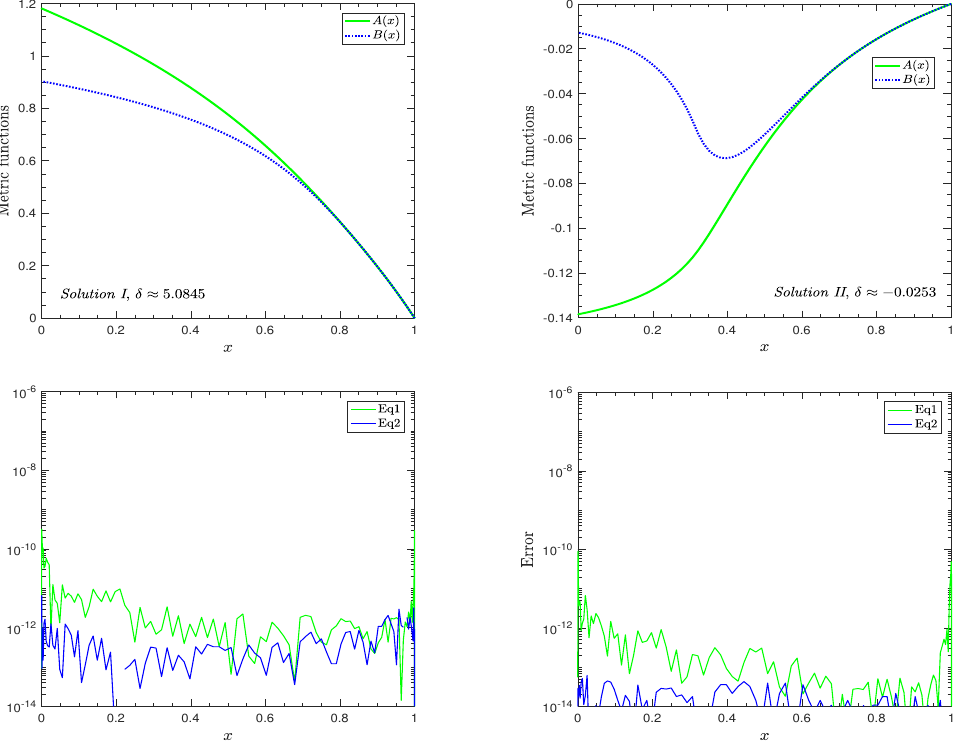
Figure 1 . Two non-Schwarzschild black holes for r 0 = 2. Top panel shows numerical results of functions A, B , and bottom panel shows the absolute value of the error in eqs. (A.1) and (A.2) { } (see appendix. A). The left and right panels correspond to solutions I and II , respectively.